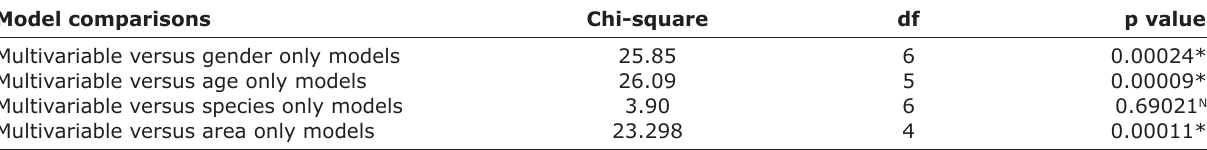
Table-8: A Comparison between the multivariable logistic regression with all univariable logistic models using the differences in